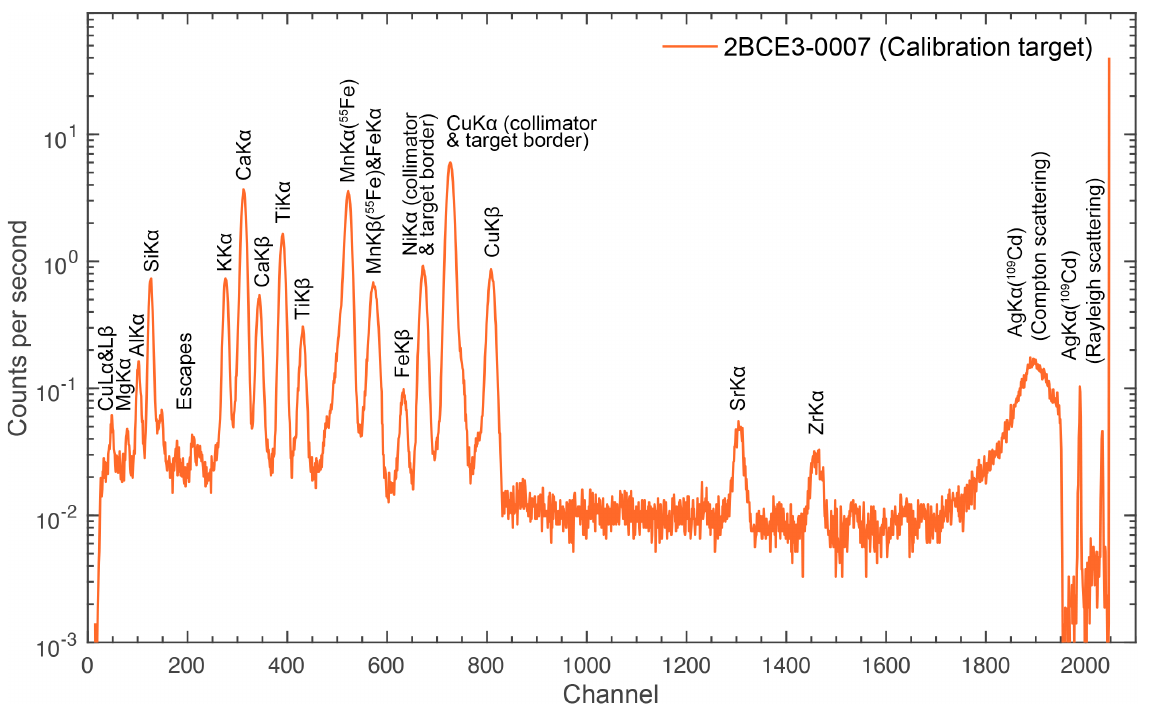
Figure 3. APXS spectrum of calibration target measured on 11 January 2014 (UTC). NiK α peak is mainly from materials in collimator and target holder. Cu peaks are mainly from collimator and target frame with copper coating.